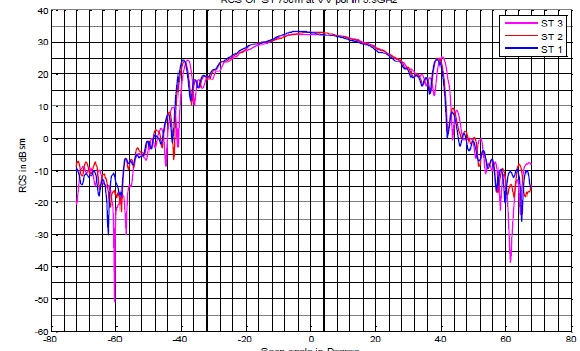
Figure 4(c): Plot of measured RCS values of